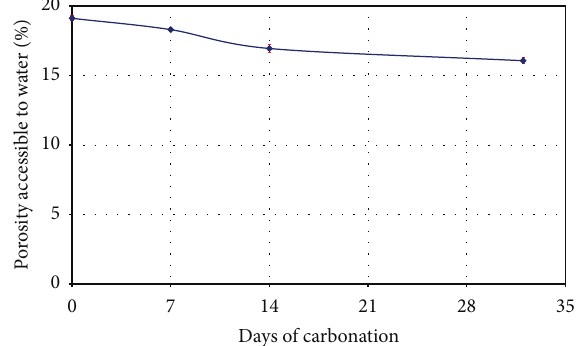
Figure 8: Evolution of the porosity accessible to water during